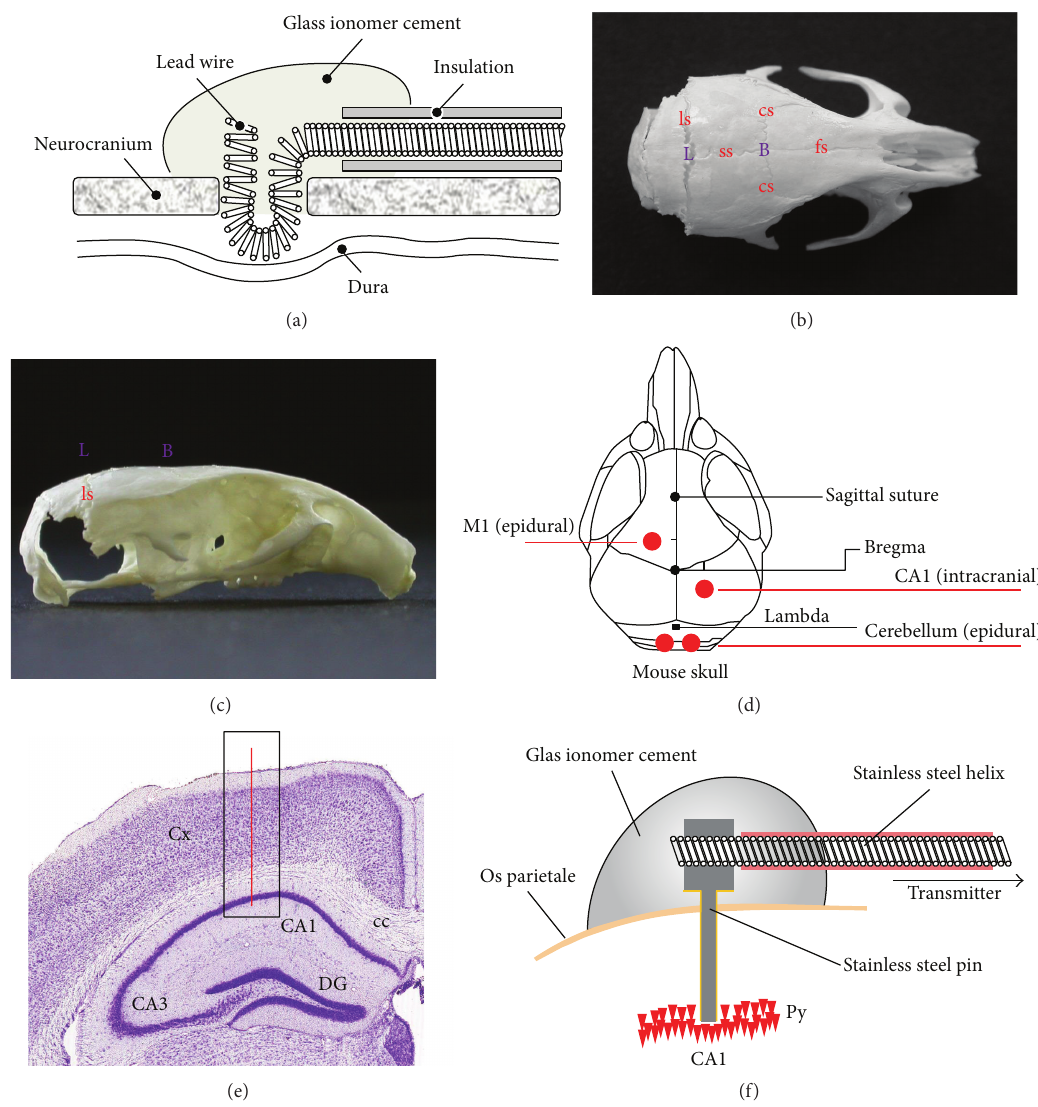
Figure 3: Stereotaxic surface and deep electrode implantation. (a) Scheme of an epidural electrode placement in mice and rats. (b) Anatomic structures and landmarks of the murine skull. Apical view of a C57Bl/6J mouse skull which has been prepared in 0.3% H 2 O 2 . Note cranial bones (os frontale (of), os parietale (op), and os occipitale (oo)) and sutures (sutura frontalis (sf), sutura sagittalis (ss), sutura coronaria (sc), and sutura lambdoidea (sl)) which determine the major anatomic landmarks bregma (B) and lambda (L). (c) Lateral view of a C57Bl/6J mouse skull. (d) One epidural, differential electrode is placed on the motor cortex (M1), and an additional intrahippocampal differential electrode is placed in the CA1 region of the hippocampus. Both pseudo-reference electrodes are localized on the cerebellum. (e) Coronal section (scheme) illustrating the localization of the deep, intracranial electrode for recording the electrohippocampogram. (f) Close-up of the deep EEG electrode, the sensing lead of the radiofrequency transmitter, and their arrangement on top of the murine skull. Figure 3(b) reprinted from [85], with permission from